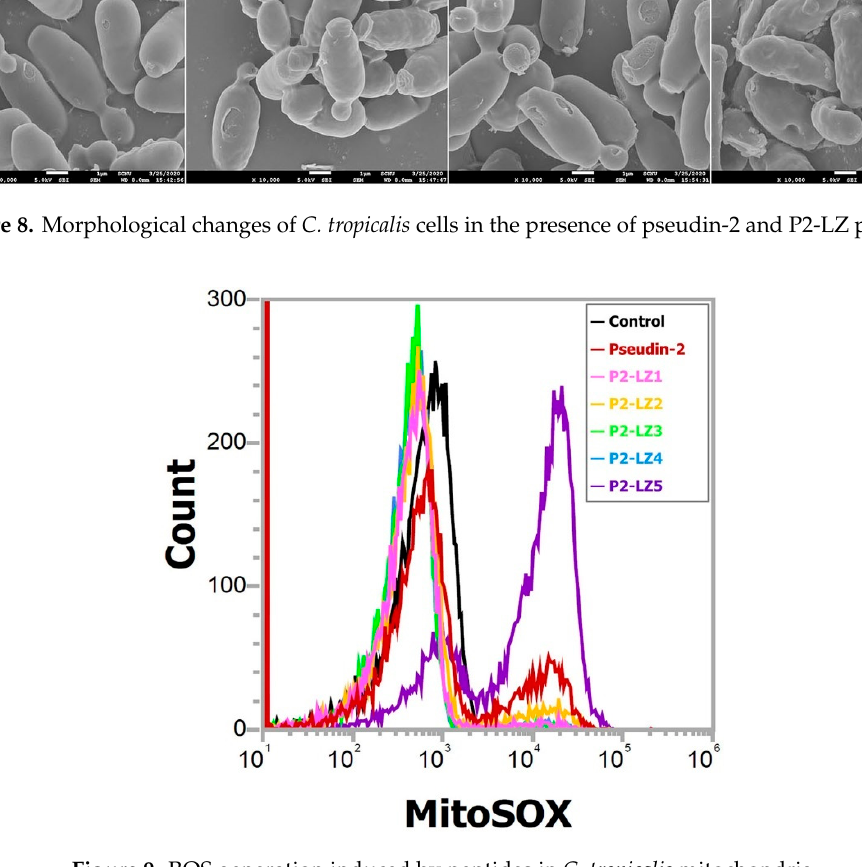
Figure 10. In vivo antifungal activity of pseudin-2 and P2-LZ4 peptides in C. tropicalis -infected mice. ( A ) At 24 h after subcutaneous fungal infection, pseudin-2 and P2-LZ4 peptides were subcutaneously injected, and mice were monitored for seven days. ( B ) Paraffin-embedded skin tissues were sectioned and stained with hematoxylin and eosin. Subcutaneous ( a ) and epidermal tissues were observed under a microscope (magnification: 400×). ( 1 ): PBS, ( 2 ): C. tropicalis , ( 3 ): C. tropicalis with pseudin-2, ( 4 ): C. tropicalis with P2-LZ4. 2.5. In Vivo Antifungal Effects C. tropicalis induces various infectious diseases, including oropharyngeal candidiasis, oral thrush, vulvovaginal candidiasis, angular cheilitis, pulmonary candidiasis, and gastrointestinal